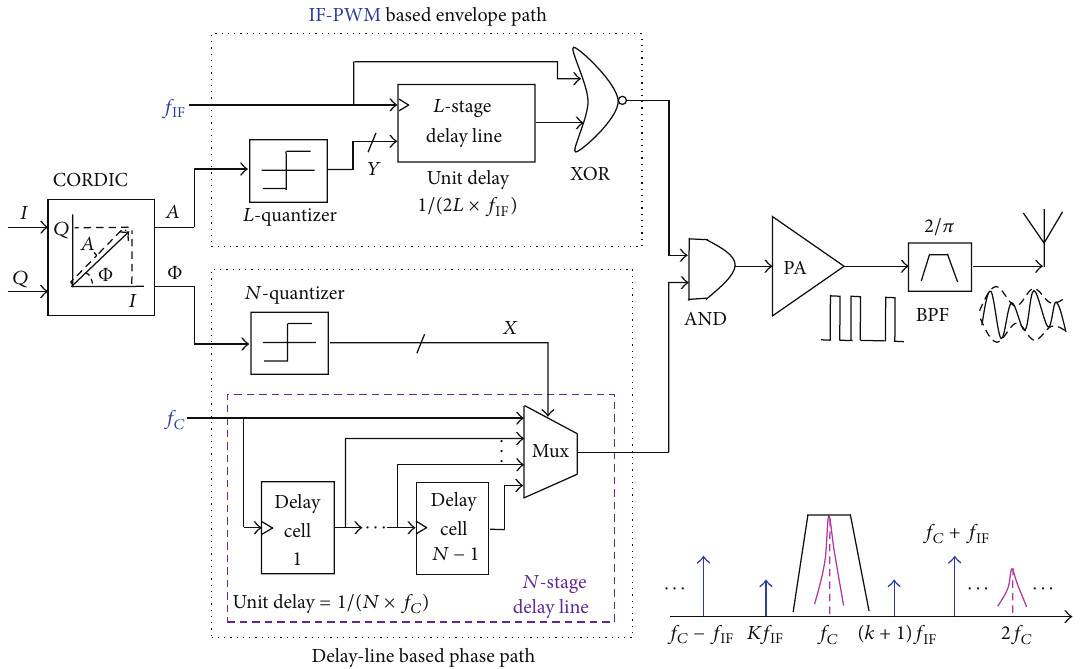
Figure 2: Delay-line based IF-PWM mode for proposed fully digital transmitter.